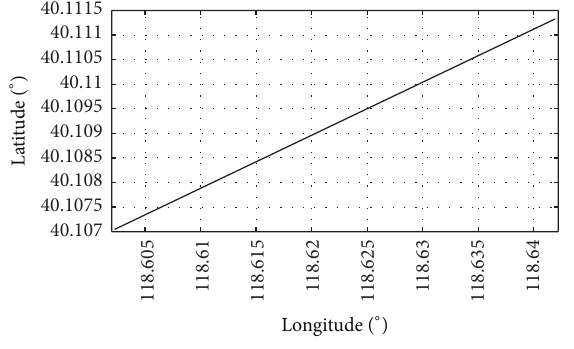
Figure 1: The track of land vehicle.